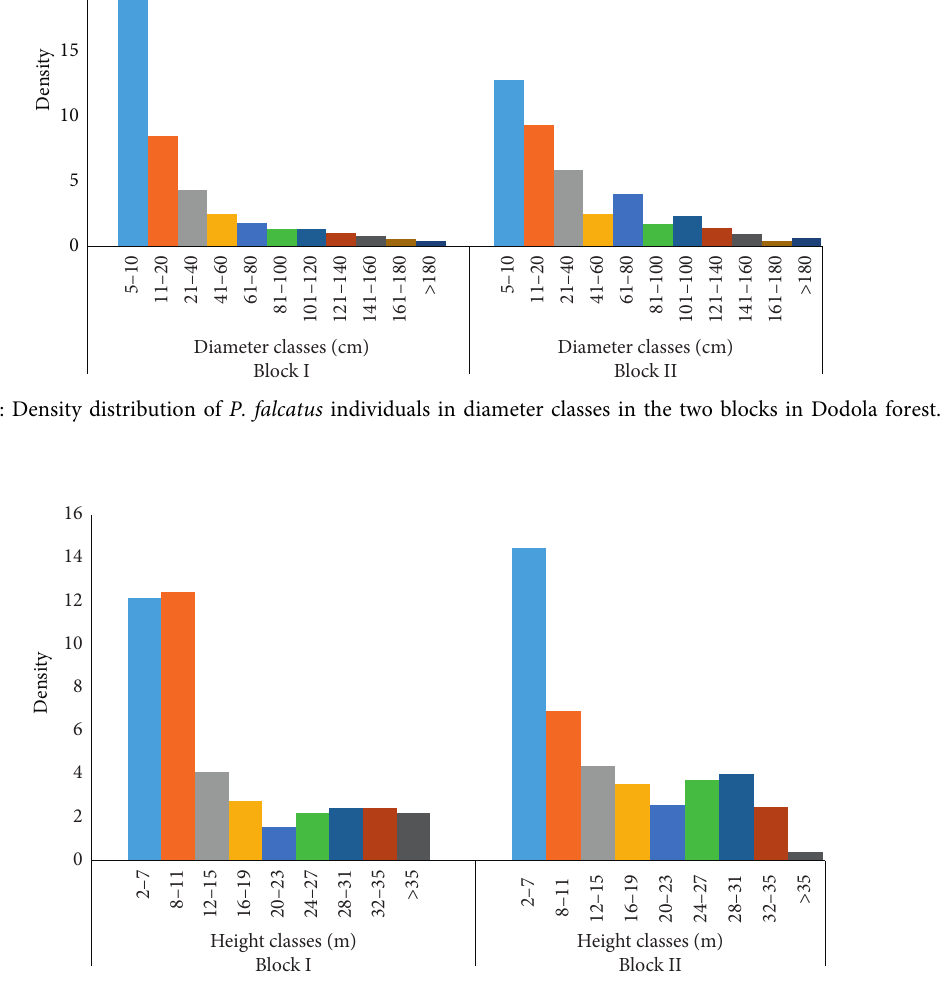
Figure 5: Height distribution of P. falcatus in height classes in the two blocks in Dodola